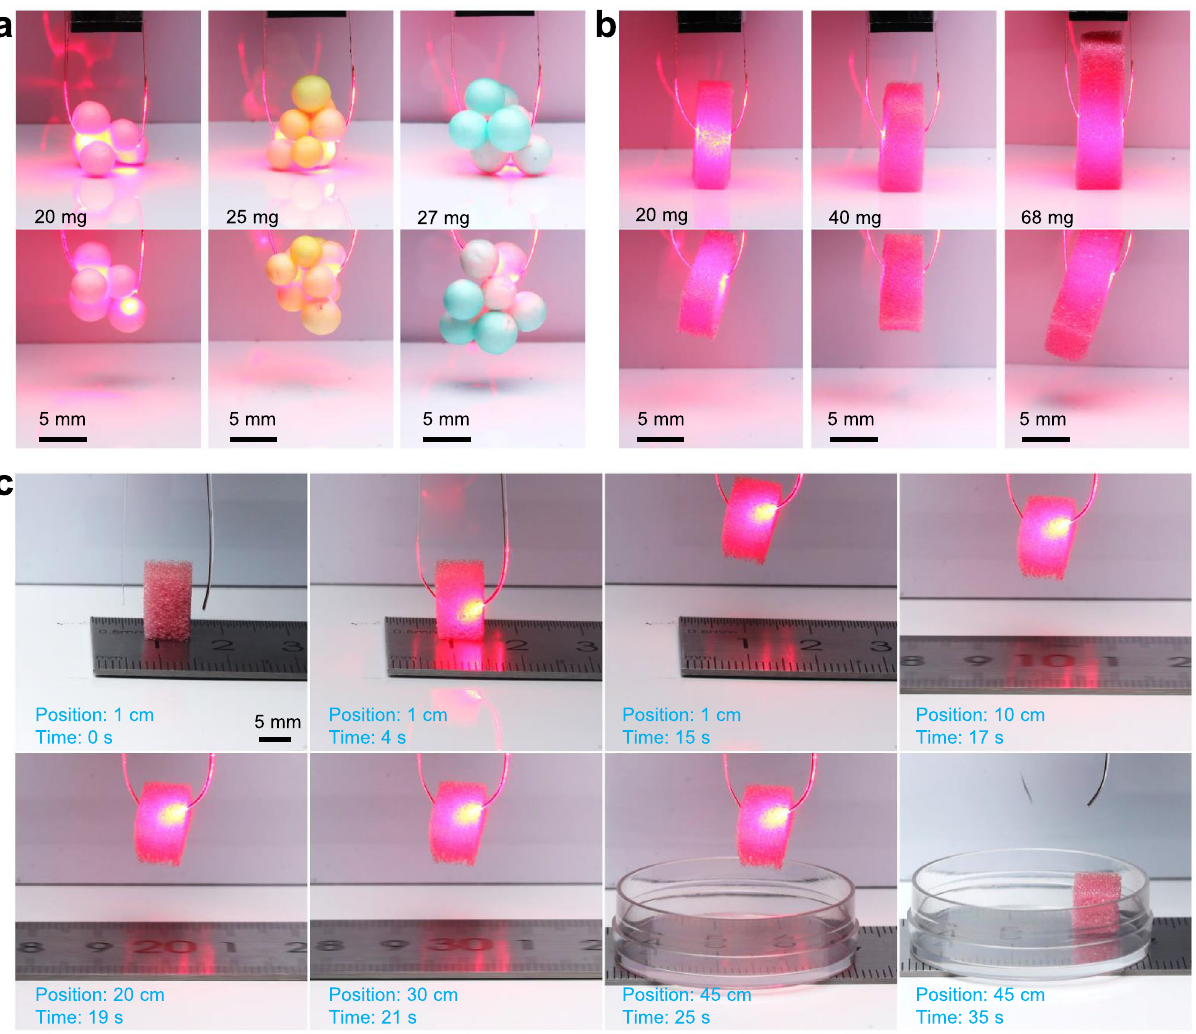
Fig. 5 Two-arm OPA soft gripper captures and moves objects. a Photographs of capturing glued balls of different weights with a two-arm OPA gripper. b Photographs of capturing cuboids of different weights with a two-arm OPA gripper. c Photographs of handling a cuboid in a long operating distance with a two-arm OPA gripper fi xed on an electric